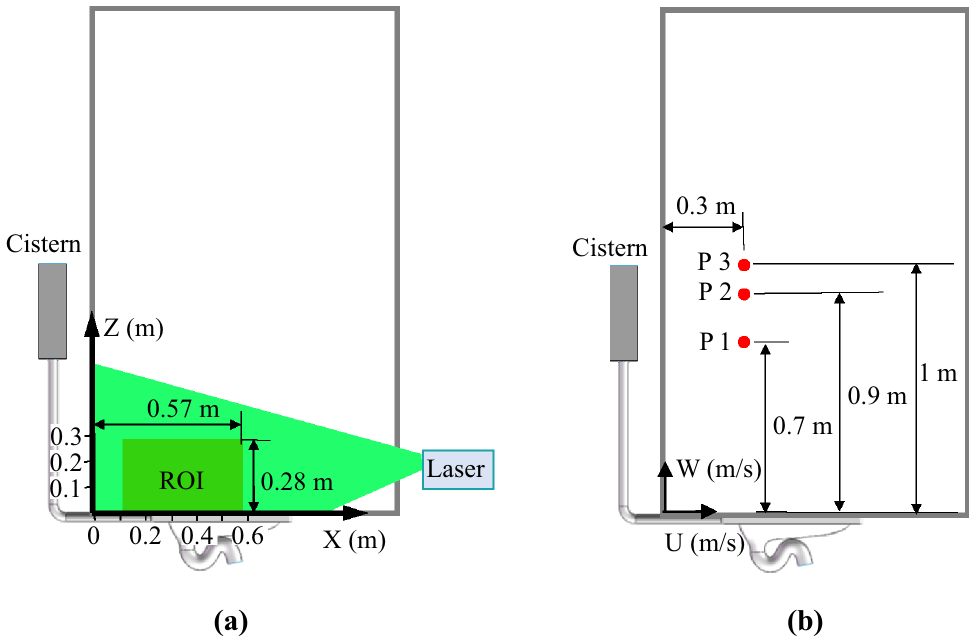
Figure 12. The region or locations for velocity measurement: ( a ) the region of interest (ROI) for the PIV measurement, ( b ) the points for velocity measurement with an ultrasonic anemometer.